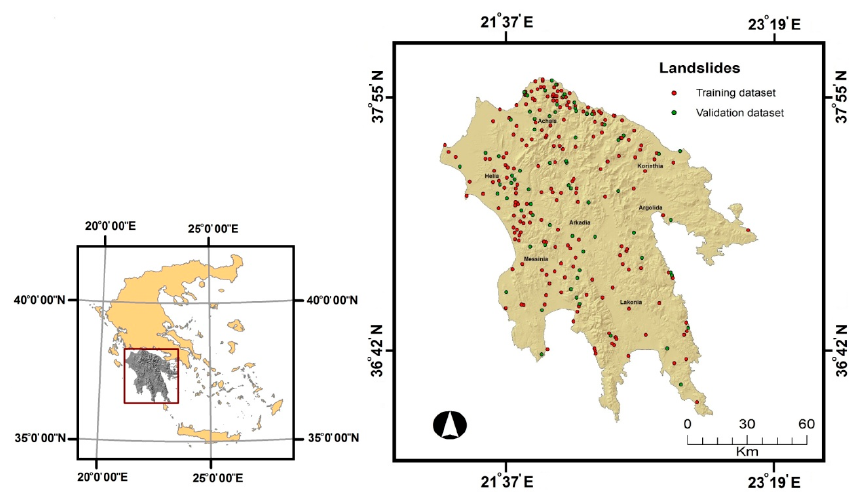
Figure 1. The location of the study area (Peloponnese peninsula) and the landslide inventory.